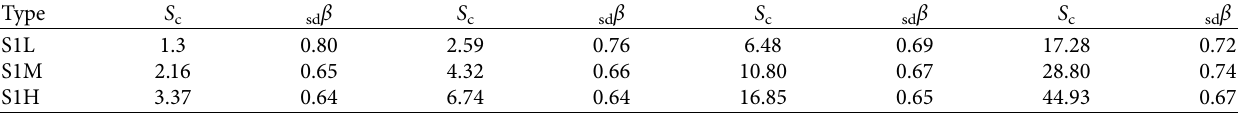
Table 5: Values provided for S c and β sd for Steel moment frames in HAZUS MH-MR4 instruction. Type